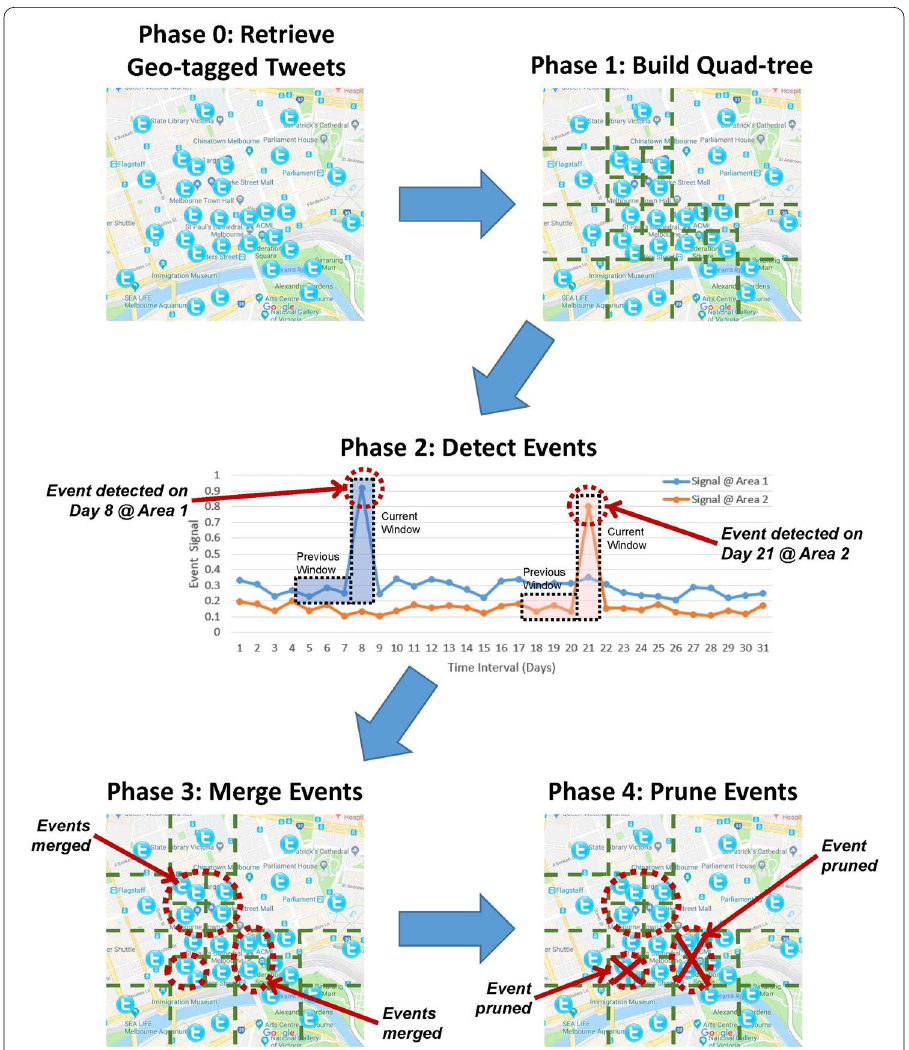
Fig. 1 Overview of our proposed Spatio-temporal Online Event Detection Algorithm.